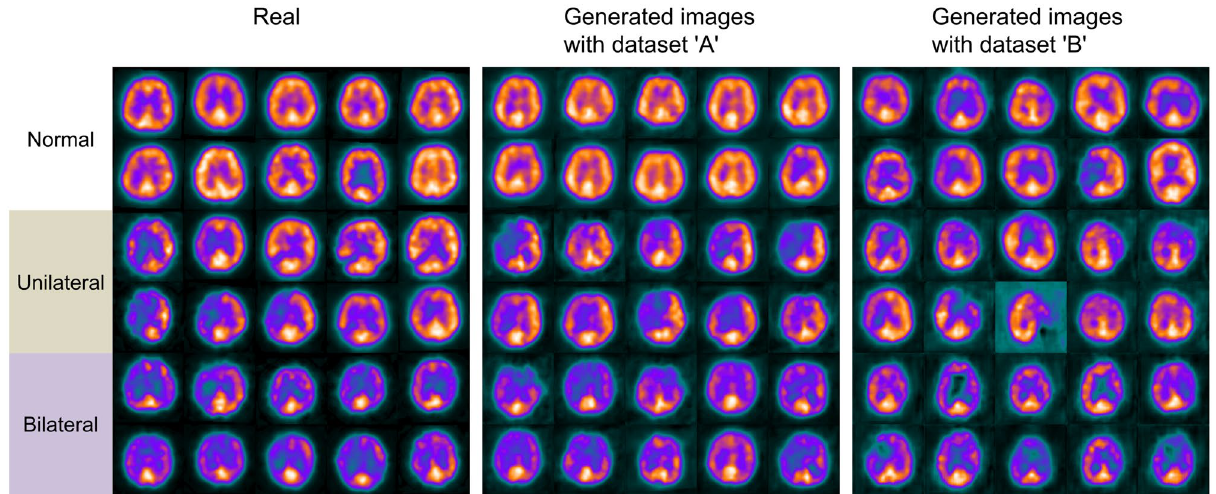
Figure 4. Real images, generated images trained with dataset ‘A’ (with three-compartment levels serving as stimuli), and dataset ‘B’ (only providing one anatomical level as input). On a visual assessment, dataset ‘A’ including more anatomical information resembles real images more closely than generated images by dataset